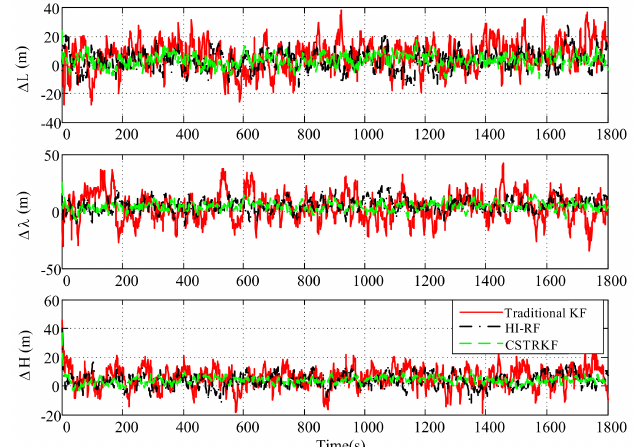
Figure8. VelocityerroroftheINS / SRS / CNSintegratedsystemwithdi ff erentfiltersunderacontaminated Gaussian measurement noise condition.